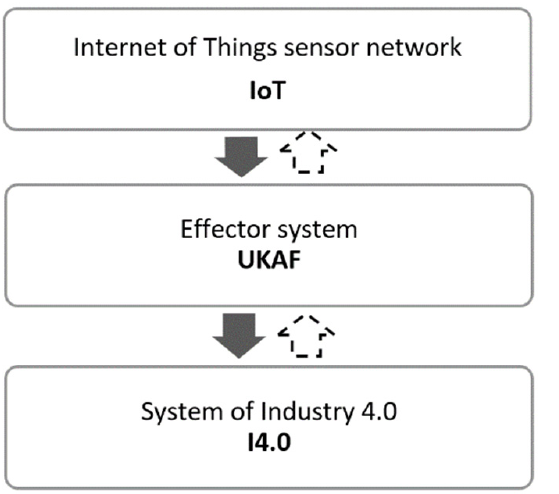
Figure 2. A simplified model of anticipatory management of systemic uncertainty in an IoT network. Source: [11].